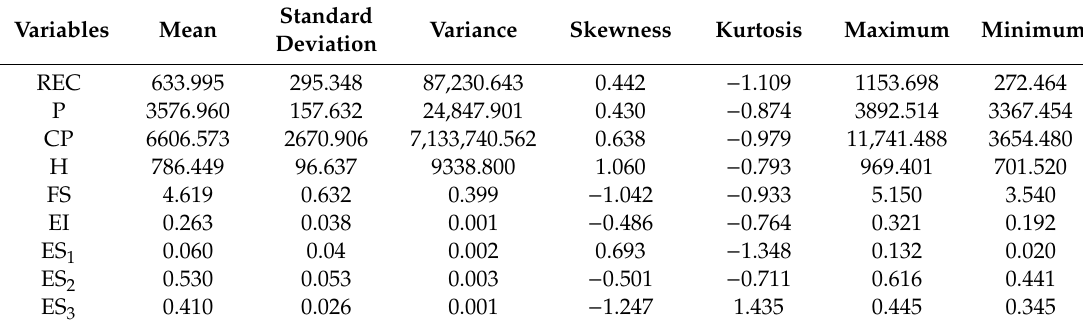
Table A2. Descriptive statistics of the main variables in rural Guangdong.